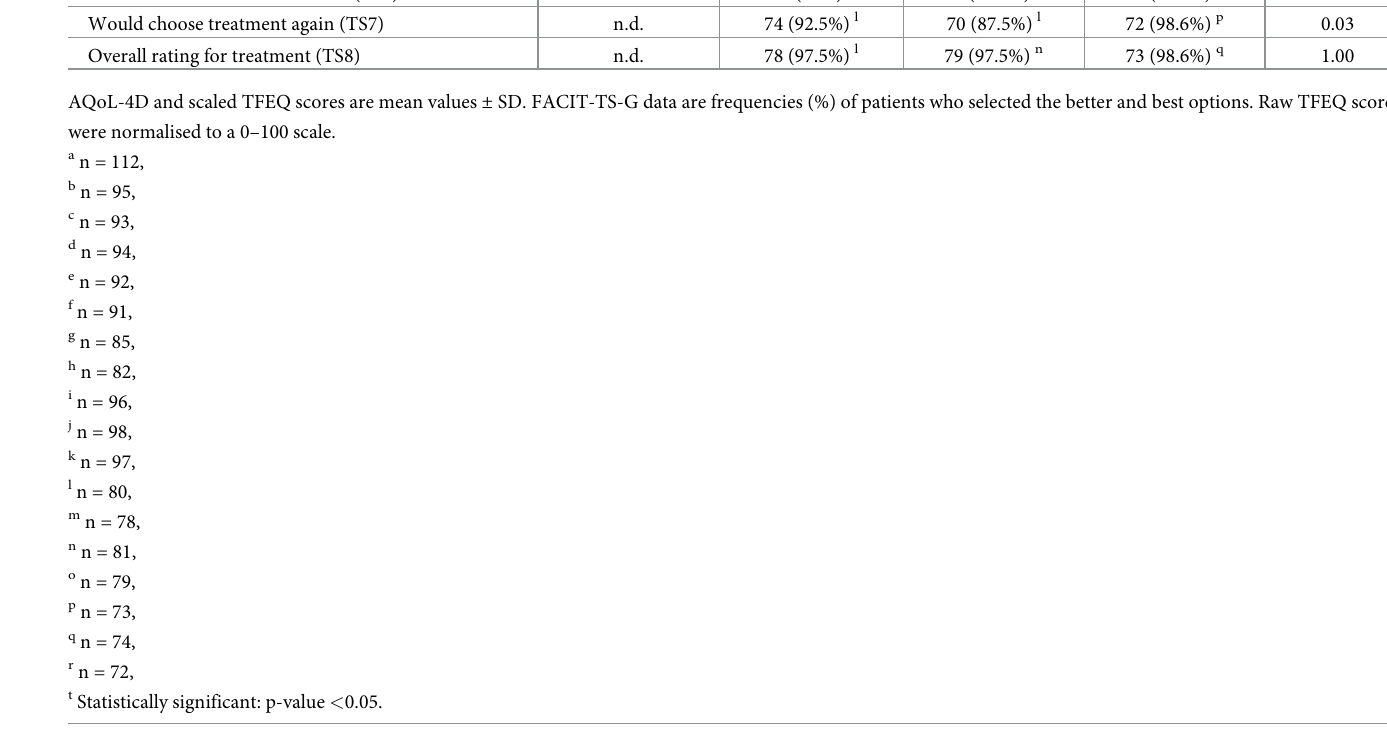
surgery v. 0.93 ± 0.14 by 12 months, Table 2) and mental health (0.81 ± 0.14 pre-surgery v. 0.87 ± 0.12 at 12 months domains). Patients’ satisfaction with the service and surgery was measured with the FACIT-TS-G and the frequency of patients selecting the ‘better’ or ‘best’ options was considered indicative of sat- isfaction. While overall approval for the treatment remained above 97% from three months post-surgery, satisfaction with the surgical side effects was initially low (55% at six months,